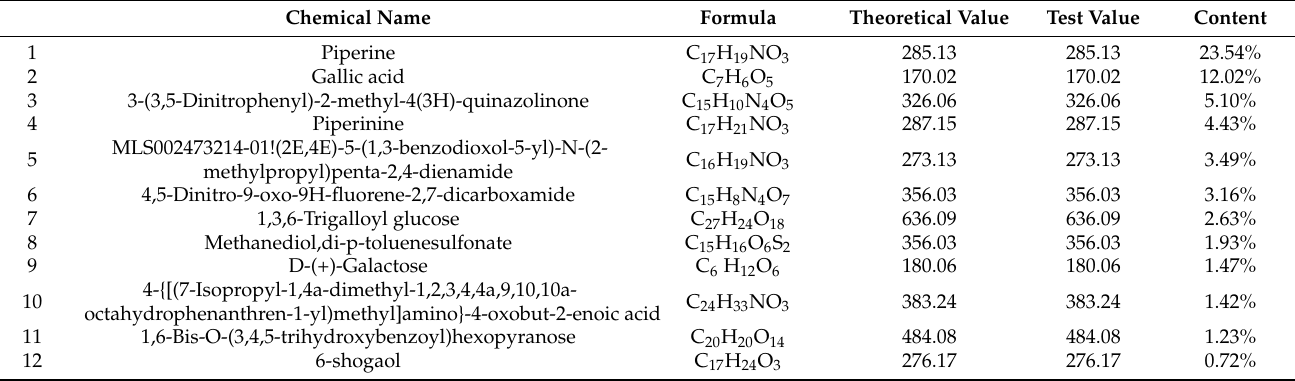
Table 4. HPLC-MS/MS identification of MD-4 aqueous extract.